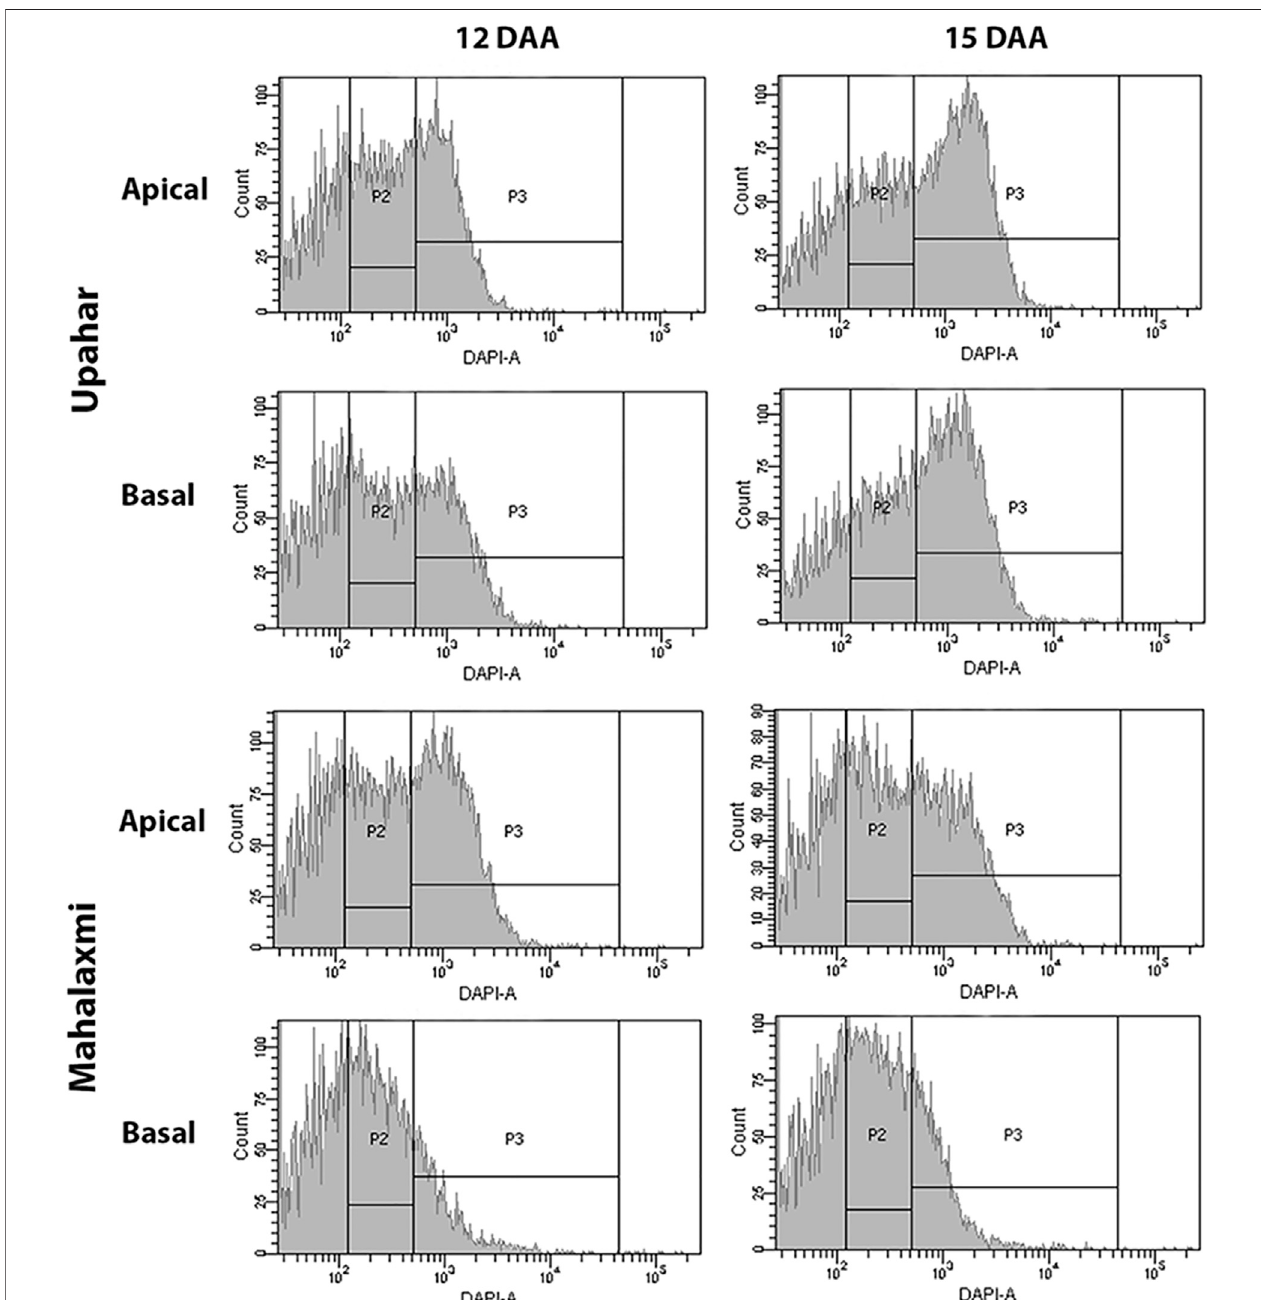
FIGURE 6 | Ploidy status of the endosperm nuclei in the developing caryopses of the apical and basal spikelets during the mid-grain fi lling stages (12 and 15 days after fertilization, DAF) in a lax-panicle cultivar, Upahar, and a compact-panicle cultivar, Mahalaxmi. The gates P2 and P3 represent the ploidy statuses 3C and > 3C, respectively. The ploidy statuses of both apical and basal spikelets in Upahar are more or less similar, whereas they differ greatly in Mahalaxmi with the basal spikelet showingamuchlessernumberoftheendospermnucleihavingtheploidystatusof > 3Ccomparedwiththatoftheapicalspikelets.Reproducedwiththepermission of the author (Sahu et al.,